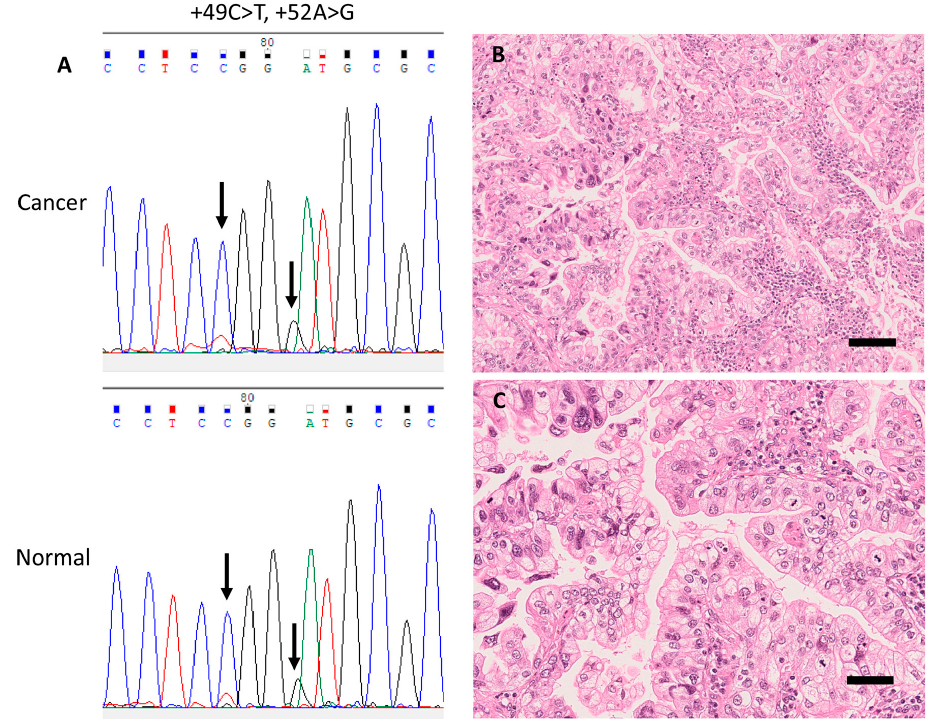
detected in these cases.